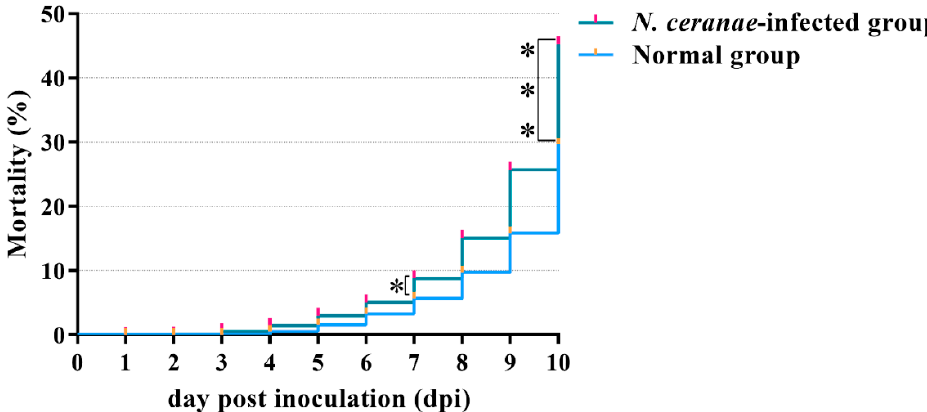
Figure 1. The accumulated mortality rate of A. m. ligustica workers in N. ceranae -infected group and normal group. Log-rank test: * indicates p < 0.05; *** indicates p < 0.0001.